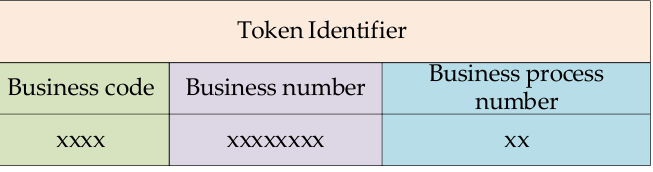
Figure 4. Token identifier.